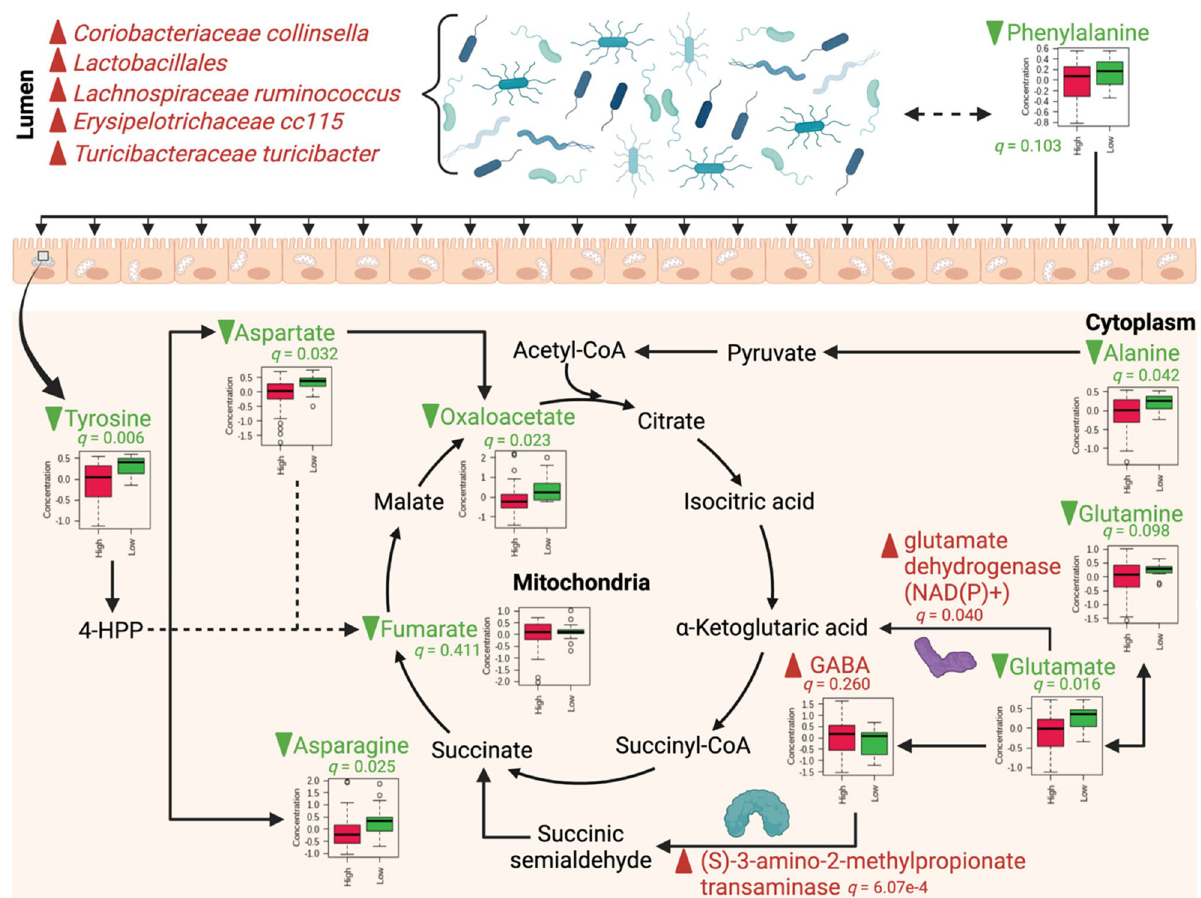
Figure 9. Integrated hypothesis of the potential pathophysiology underlying high screen time. The conceptual schema was synthesized using results of pathway topology analysis, PICRUSt analysis, and mmvec analysis. Green lettering with downward green arrows denotes decreases in the high screen time group, while red lettering and upward red arrows denotes increases in the high screen time group; box plots and significance information is provided where appropriate. Significance of plotted metabolites derived from independent t -test with FDR correction. Created with